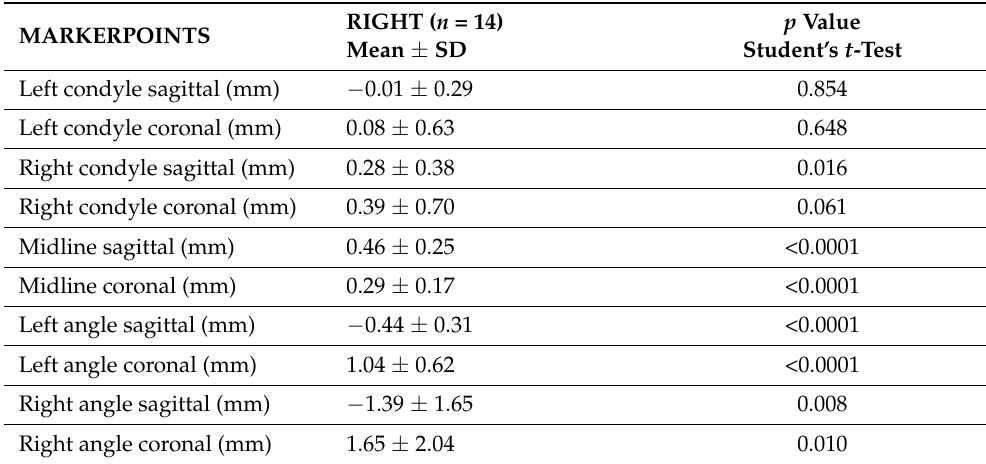
Table 4. Comparison between mean values of marker points measure and zero for patients treated on right-hand side. p value < 0.5 has been considered